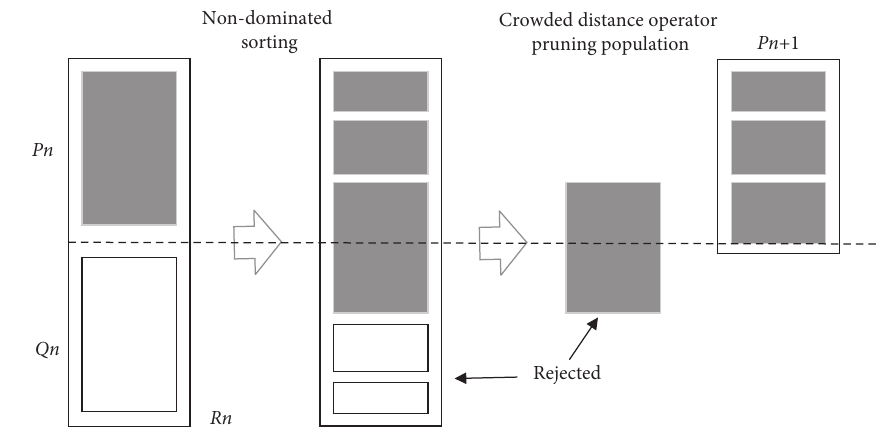
Figure 4: Basic flow of the NSGA-II algorithm.